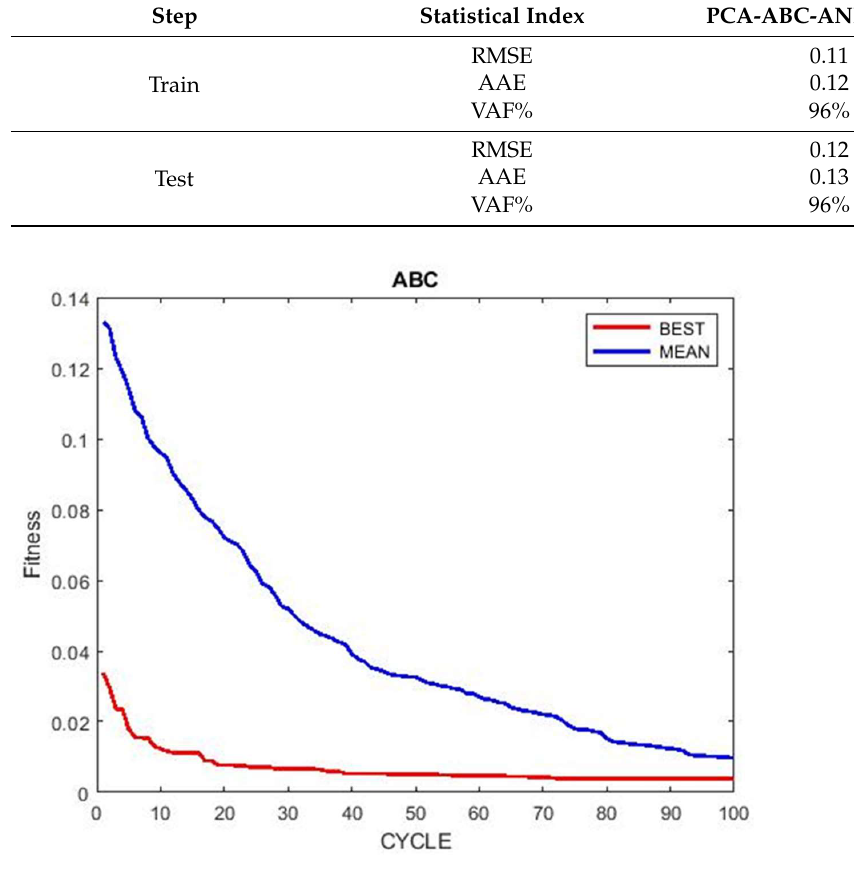
Figure 8. Cost graph for 100 replications of the PCA-ABC-ANN model as the best model.